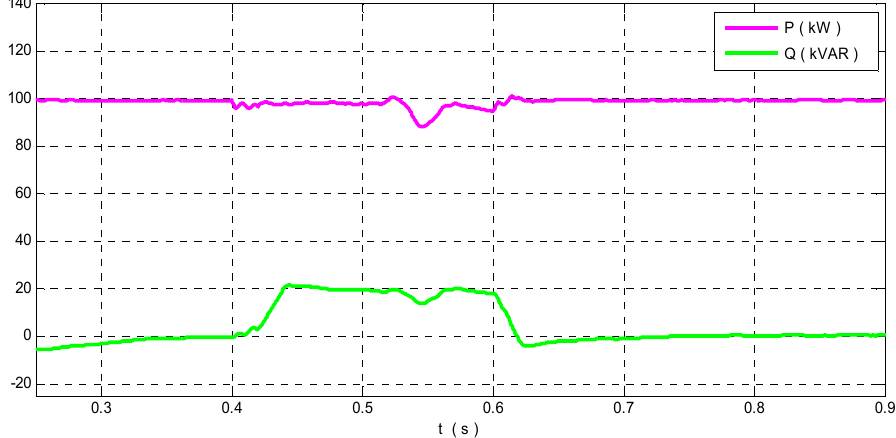
Figure 22. Voltage and current signals (phase c).